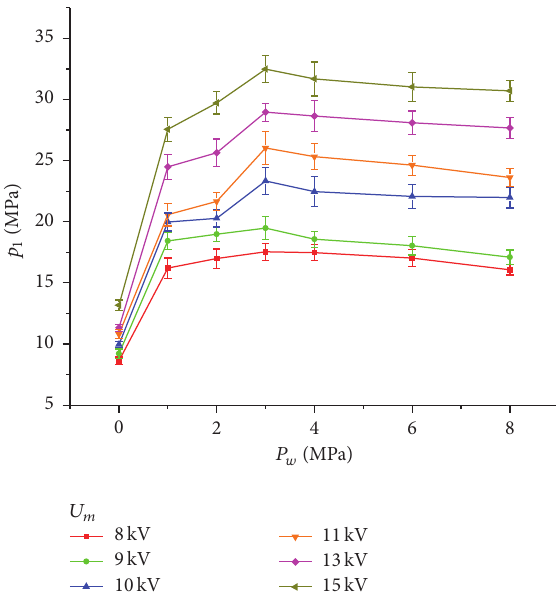
Figure 9: Peak pressure of the incident shock wave at sensor 4, 2.5 m from the